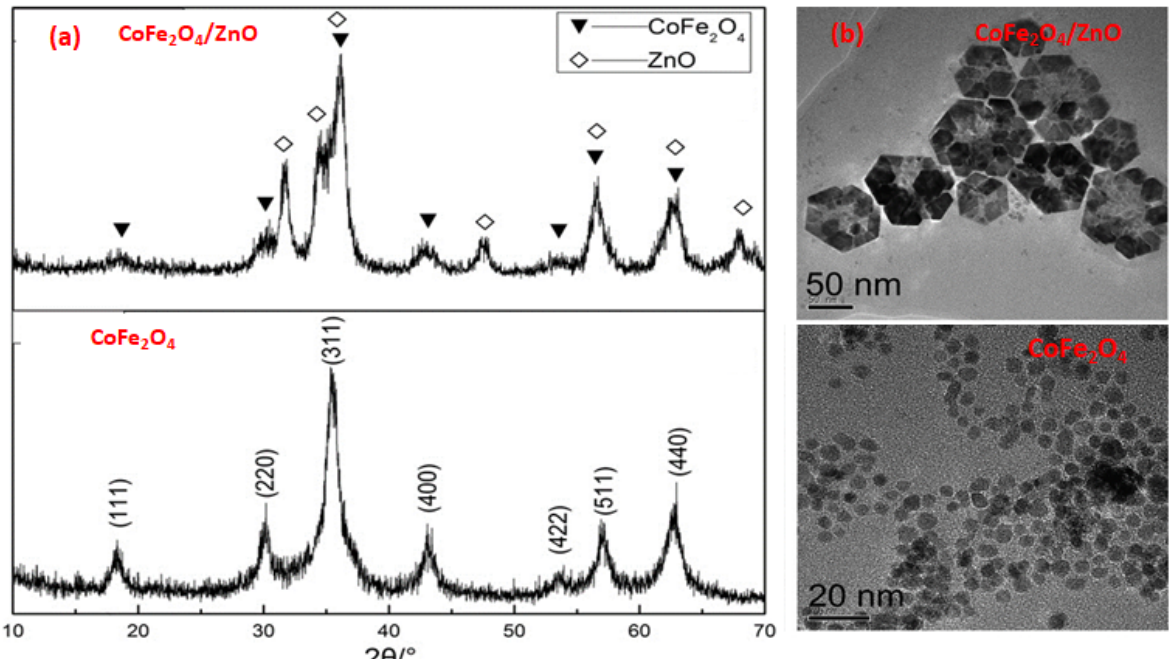
Figure 7. ( a ) XRD structural and ( b ) TEM micrographs of CoFe 2 O 4 and magnetic CoFe 2 O 4 /ZnO nanocomposites [97]. Republished with permission from Elsevier.